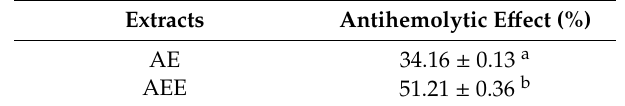
Table 3. Protective e ff ect of Annona muricata L. extracts on human